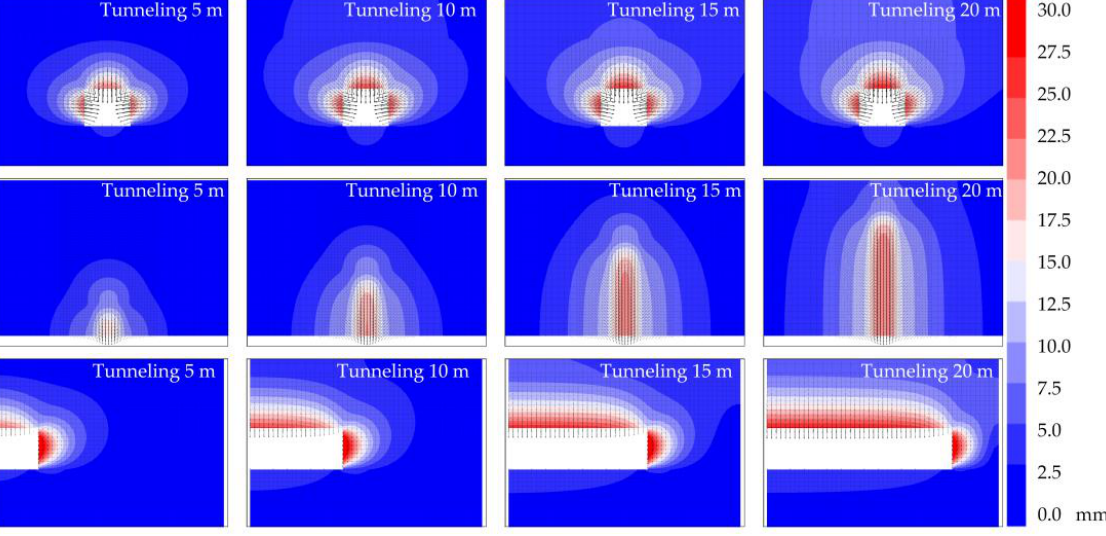
Figure 8. Three-way stress change curve of roof in heading face. 0